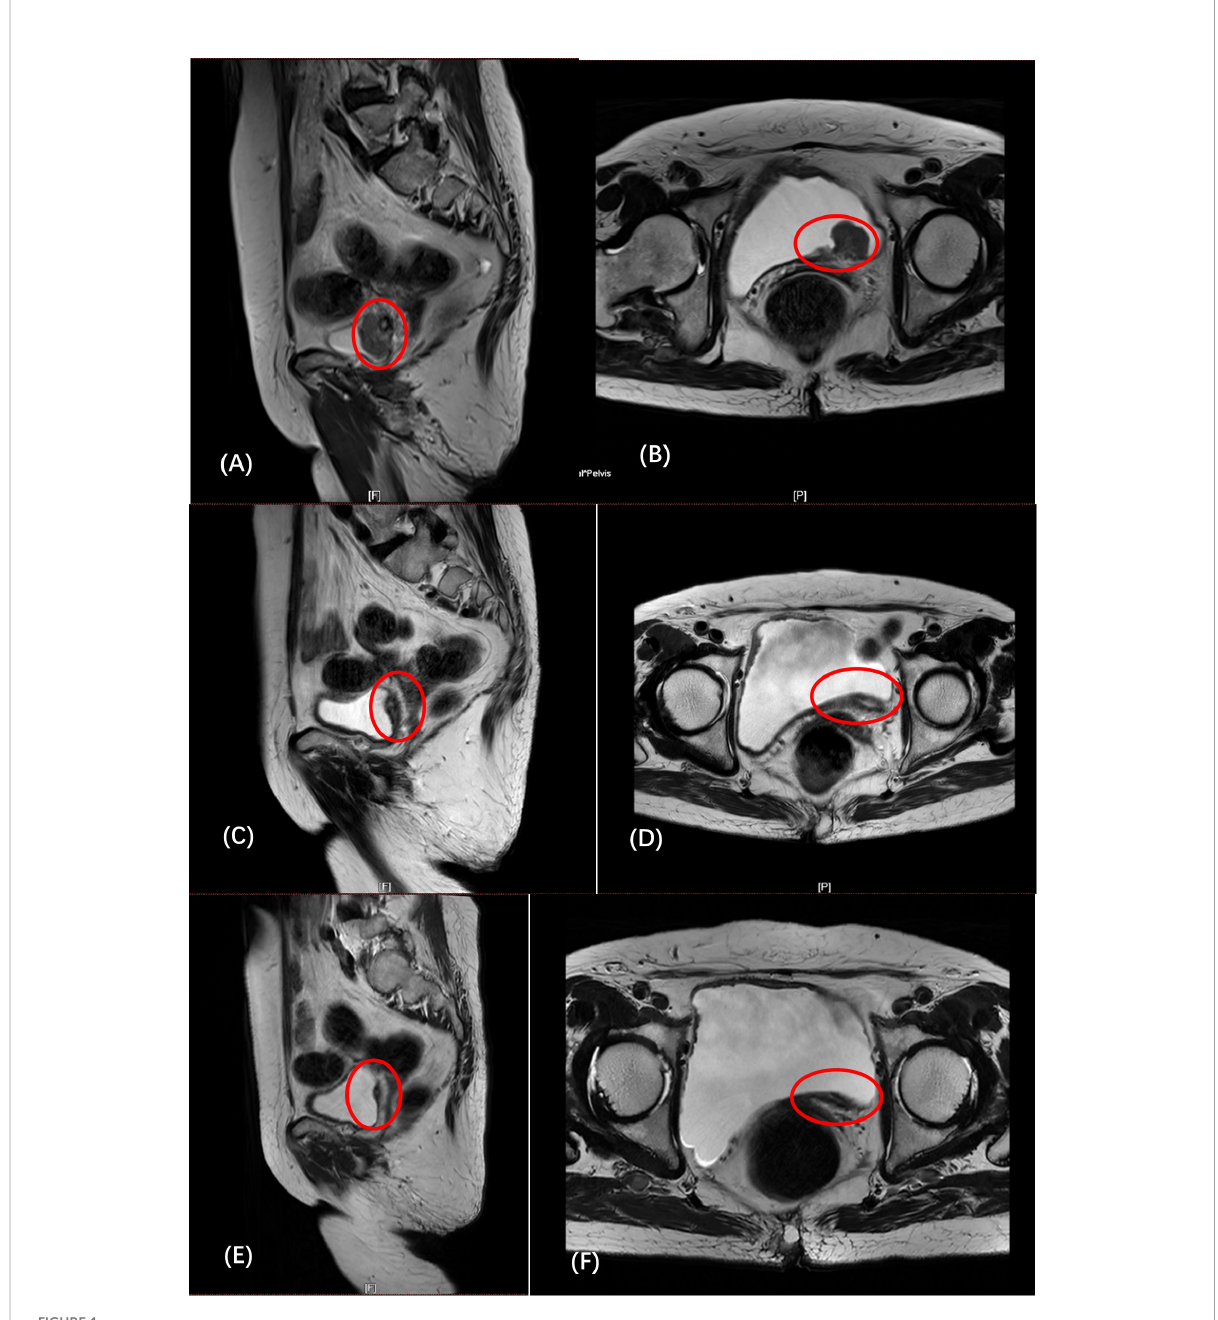
FIGURE 1 (A, B) (February 6): the left posterior wall of the bladder was unevenly thickened, and abnormal signal nodules were seen. (C, D) (April 3): compared with before, the tumor has shrunk signi fi cantly, and the lymph nodes are similar to before. (E, F) (May 26): The thickness of the left posterior wall of the bladder was reduced, and the lymph nodes remained